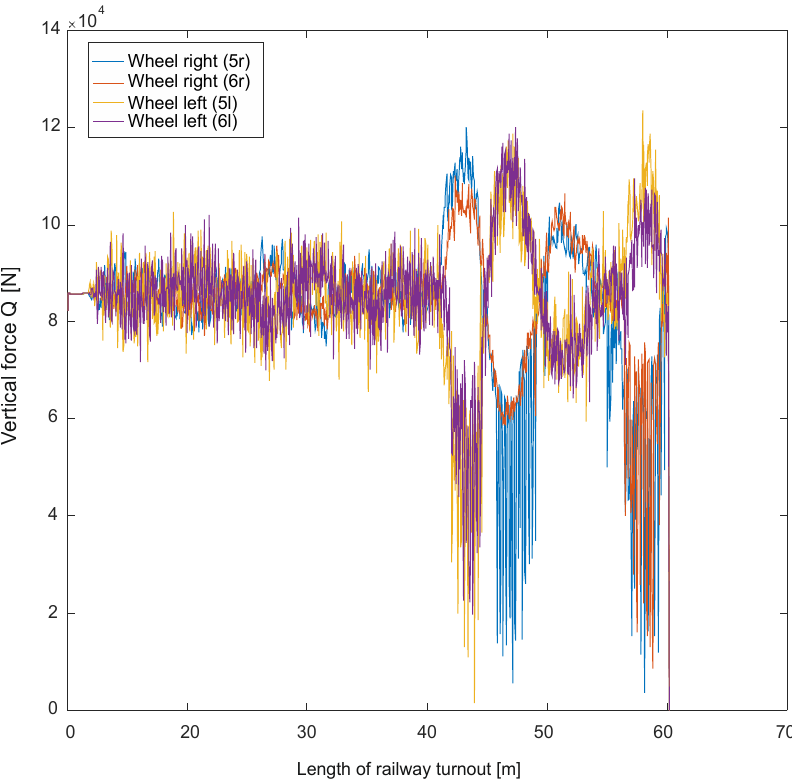
Figure 11. Vertical force at 350 km/h on a straight track through a turnout.